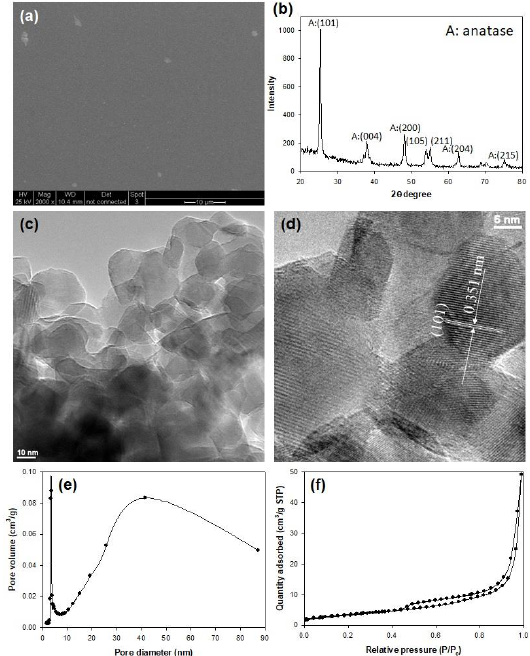
Figure 1. ( a ) Environmental scanning electron microscopy (ESEM) image of the TiO 2 film, ( b ) X-ray diffraction (XRD) spectrum of the TiO 2 film, ( c – d ) high-resolution transmission electron microscopy (HR-TEM) images of the TiO 2 film, ( e ) pore size distribution, and ( f ) N 2 adsorption–desorption isotherm of TiO 2 film.